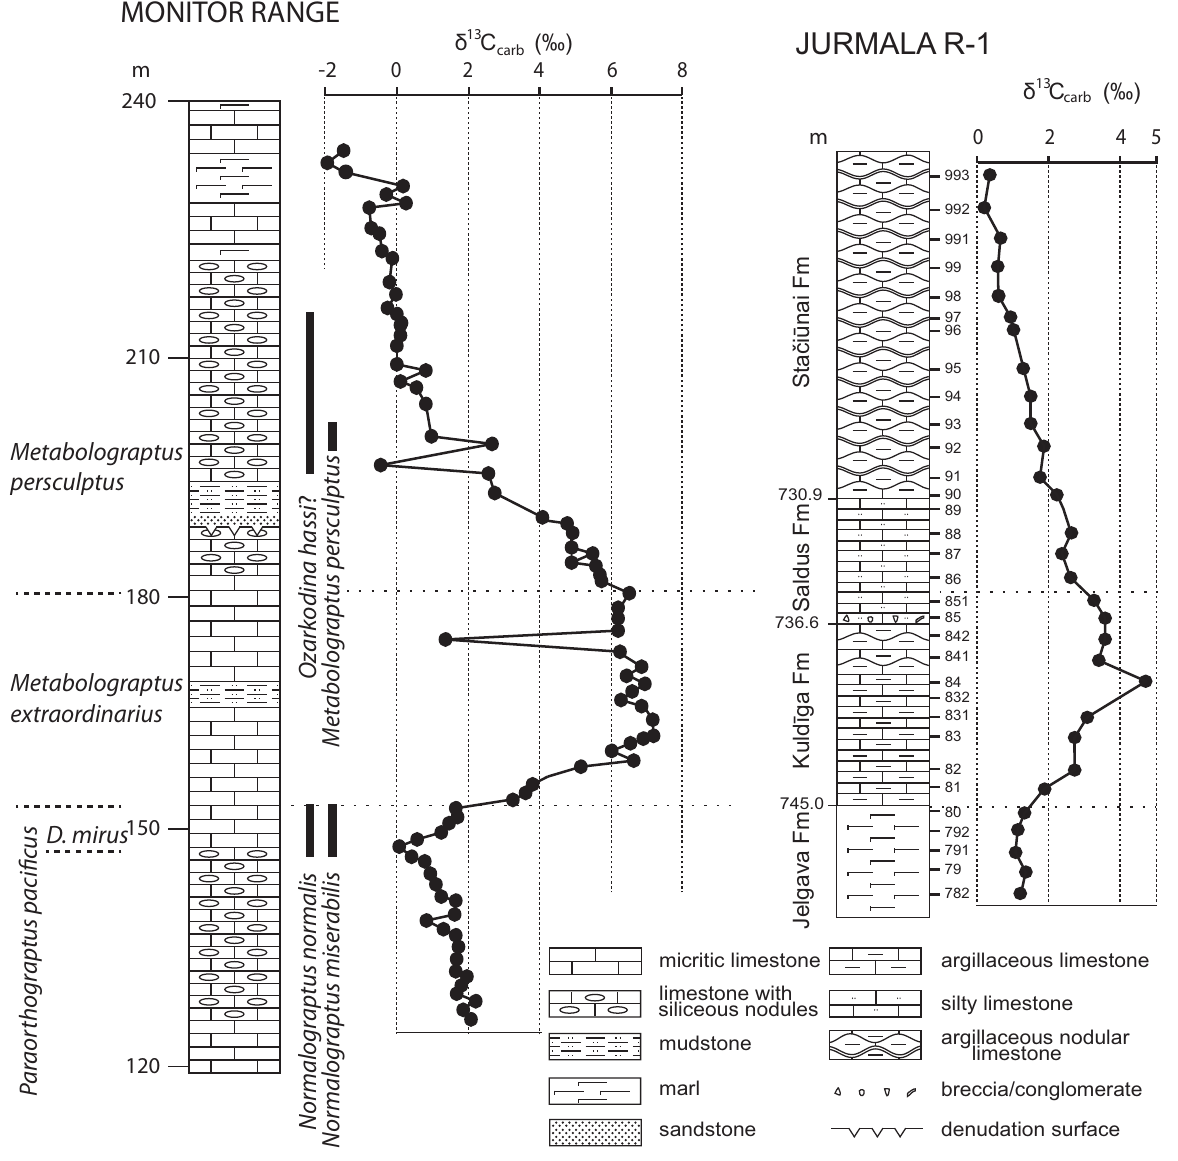
Fig. 6. Comparison of the HICE excursions in the Monitor Range section and Jūrmala core. The Monitor Range composite section is drawn after LaPorte et al. (2009), graptolite zonation and distribution of selected graptolite and conodont species are complemented after Finney et al. (1999). The isotopic curve of the Jūrmala section according to Ainsaar et al.